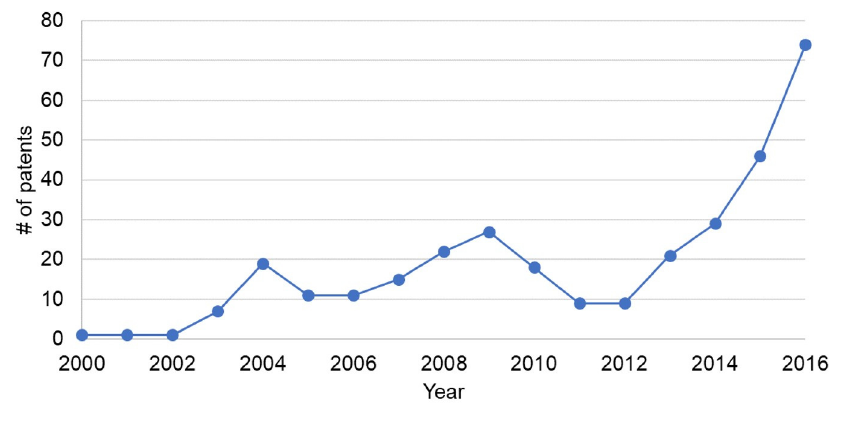
Figure 1. Number of patents for cuffless blood pressure